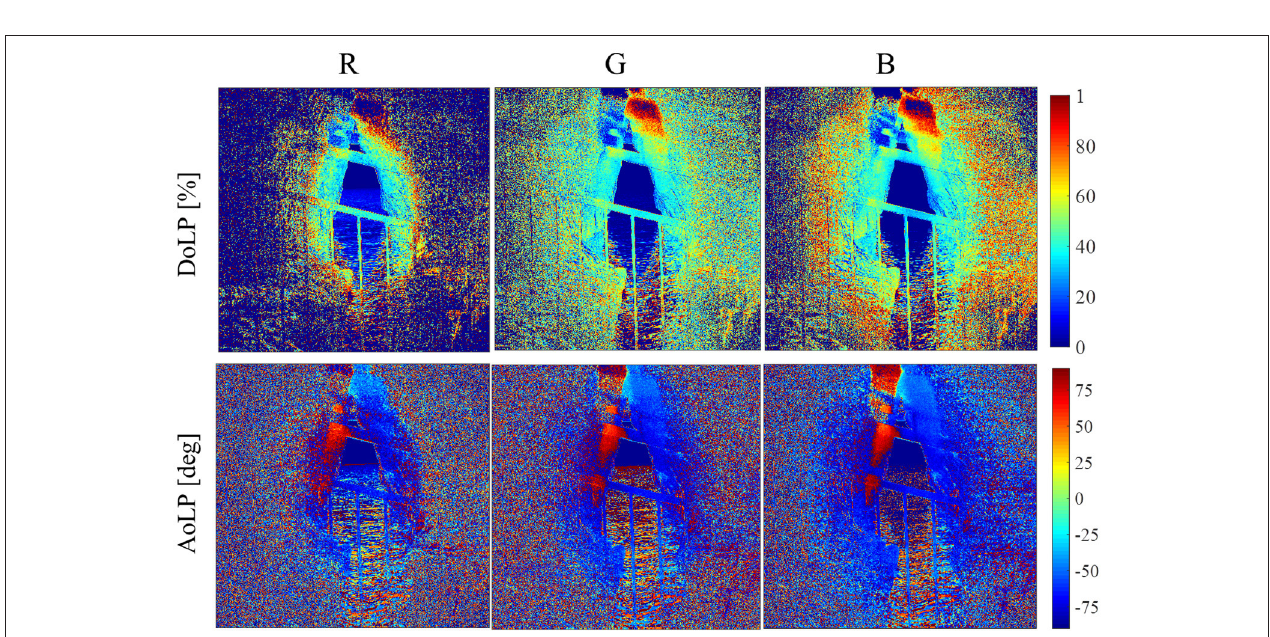
FIGURE 8 | DoLP and AoLP photos from 10:00 local time on February 14th, 2016, for the red (R), green (G), and blue (B) color bands, as obtained with long exposure time.